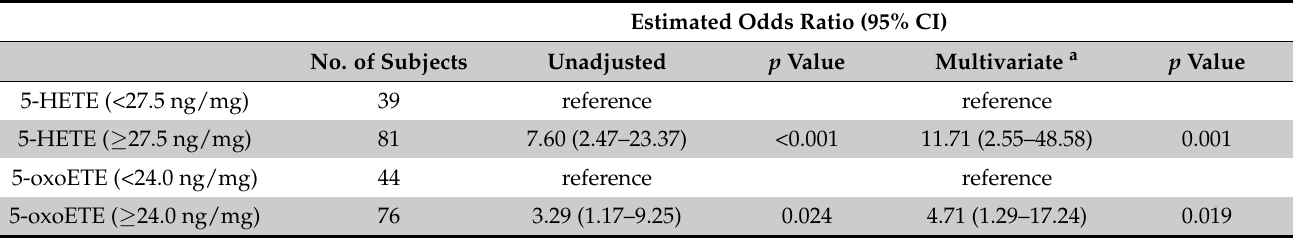
Table 3. Odds ratios of OSA according to the cutoff values of 5-HETE and